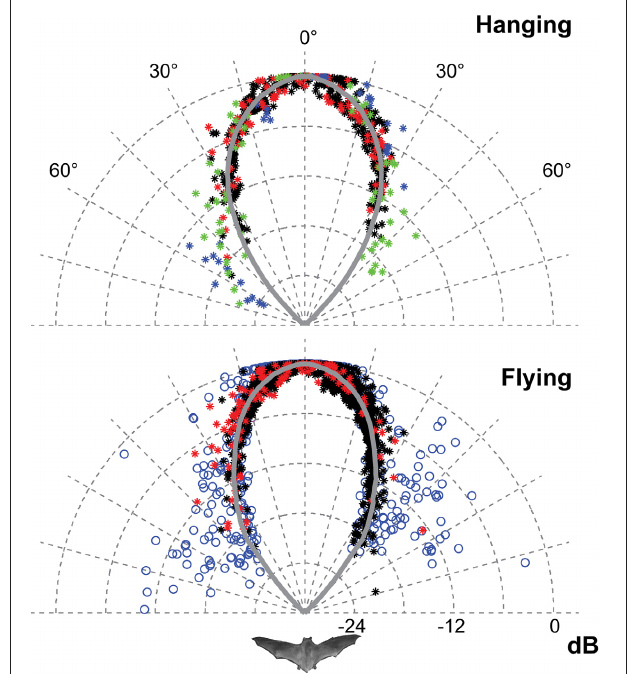
FIGURE 3 | The horizontal directionality when flying and hanging. The data for hanging bats are from 2012 (red and black) and from 2008 (blue and green). The data for flying bats are from 2012 (red and black) and from 2006 (blue). Each point is the normalised amplitude in that direction. The curves are the average of the measured values pooled in 1 ◦ bins and extrapolated using a fitted second order polynomial. Only data from 2012 was used for the traces and DI estimates because of the higher degree of control of beam aim. The sonar beam is very directional, both when flying and hanging. HAM was 18 ◦